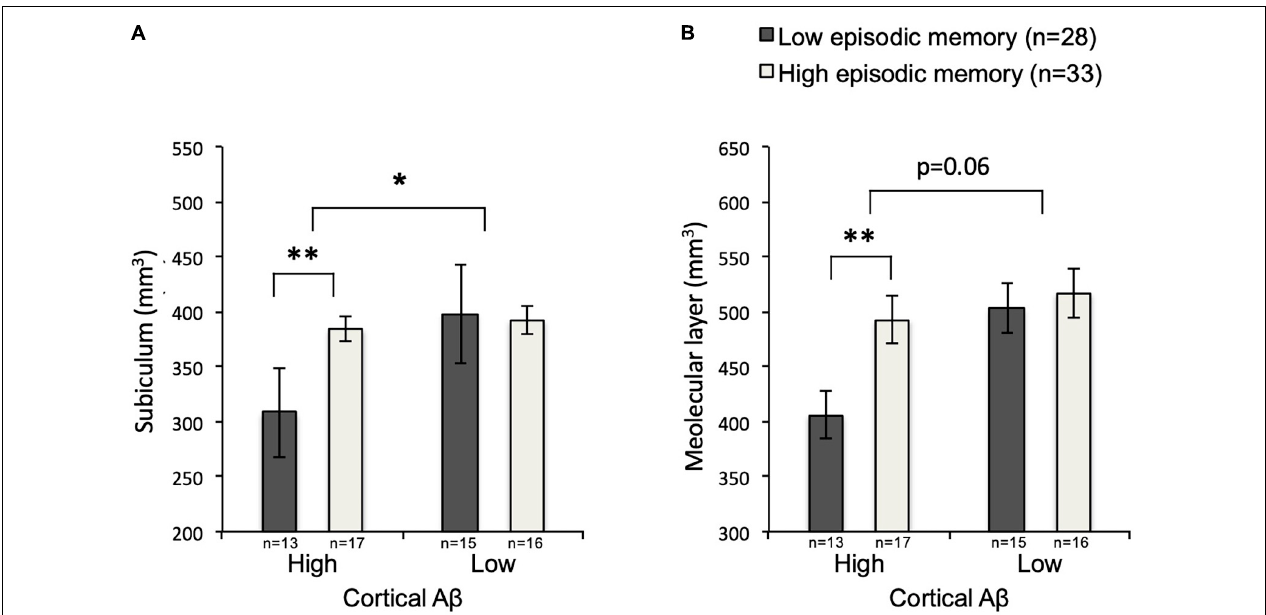
FIGURE 5 | Subiculum and Molecular layer volumes by subgroup. Mean volumes of subiculum (A) and molecular layer (B) for low-A β -high-episodic memory, low-A β -low-episodic memory, high-A β -high-episodic memory and high-A β -low-episodic memory groups with SEM, and level of significance. SEM, standard error of measurement; ∗ p < 0.05; ∗∗ p <